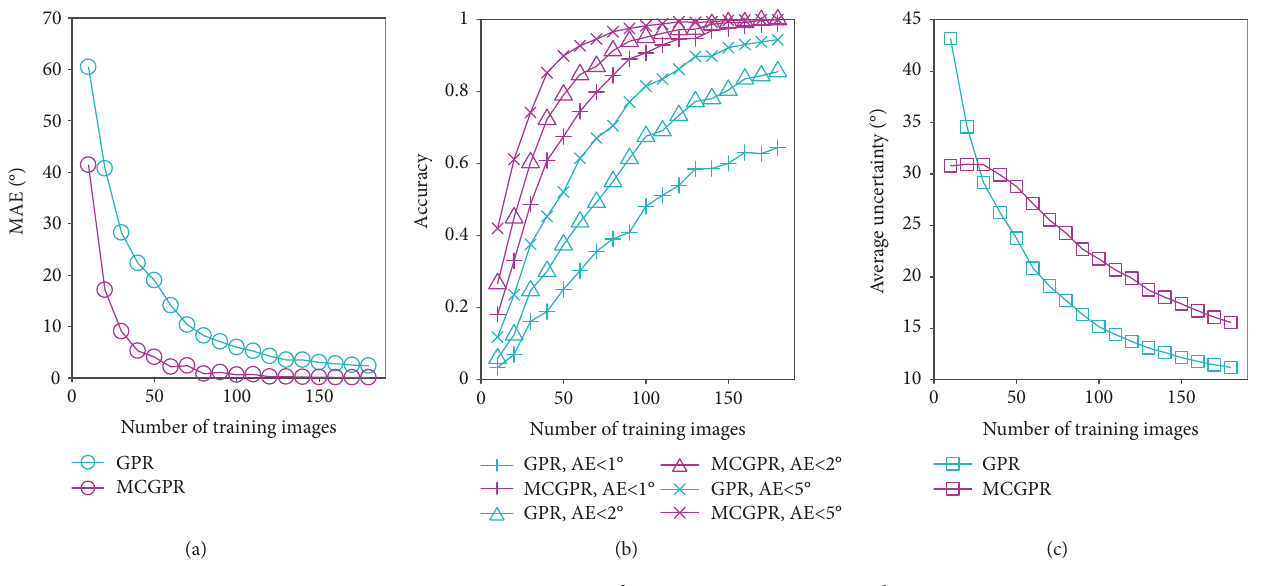
Figure 11: Pose estimation performance on sparse training data.